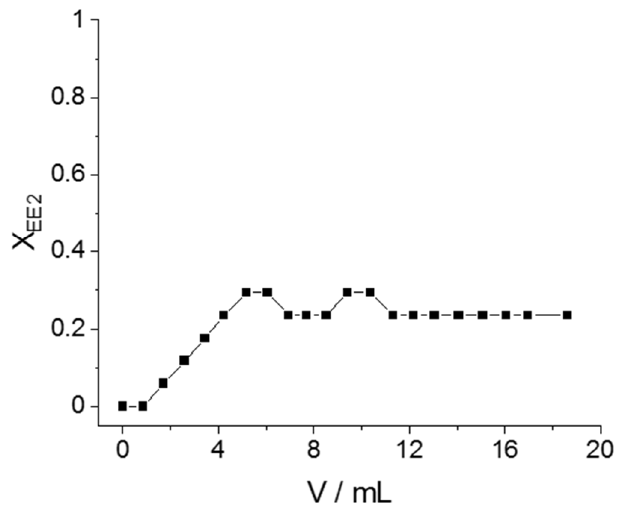
Figure 9. Investigation of the microgap reactor start up behavior; reactant: EE2 (17 α -ethinyl estradiol), c start = 14.5 µ g L − 1 , catalyst: P25 immobilized by spray coating on a steel substrate [X6CrNiMoTi17-12-2], calcination: t = 2 h, ϑ = 500 ◦ C, m = 90 mg; reaction: τ mod = 30 g min L − 1 , E = 362.5 mW cm − 2 , λ = 365 nm; EE2 content determination by UHPLC-MS/MS.